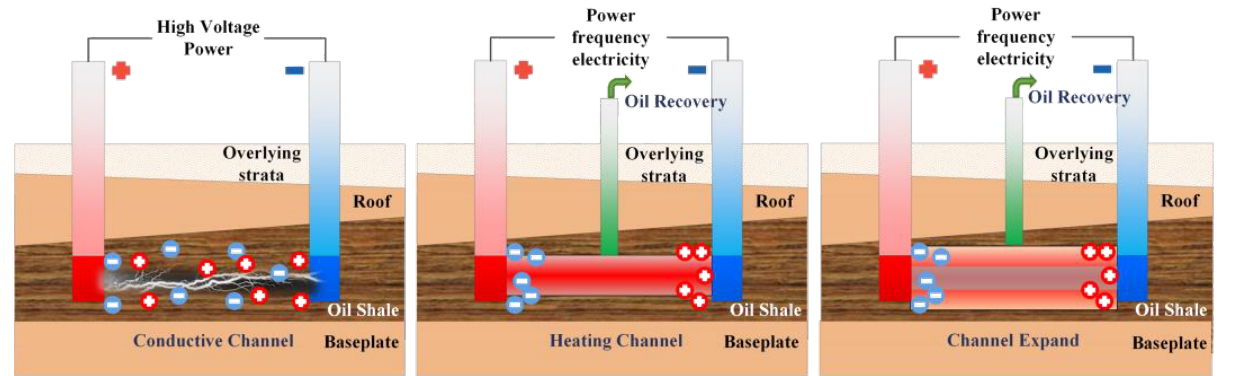
Figure 1. Schematic diagram of high-voltage power frequency electric heating in-situ pyrolyzing (HVF) processes for oil shale.